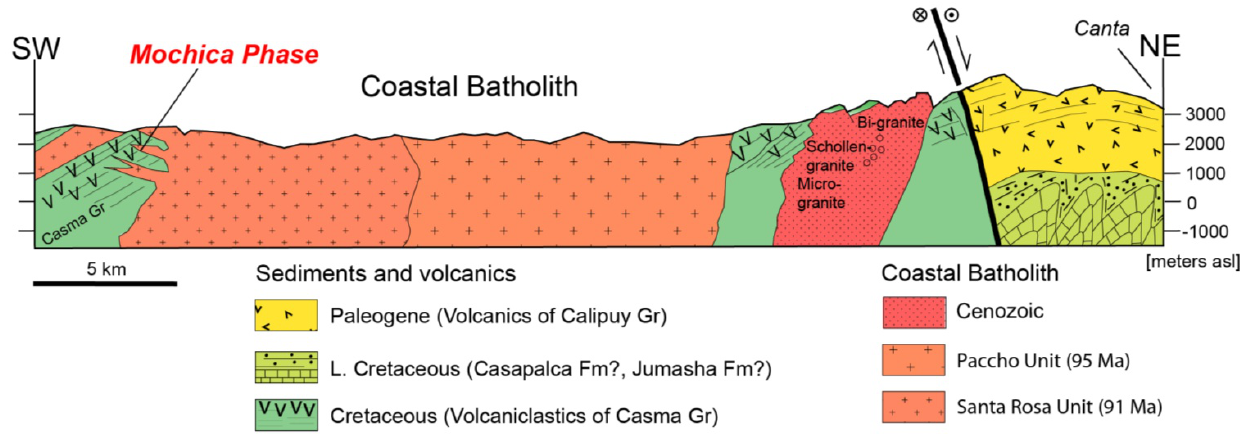
Figure 17. Deformation features linked to the Mochica Phase in the Coastal Belt in a cross-section from Santa Rosa to Canta (see Figure 7 for